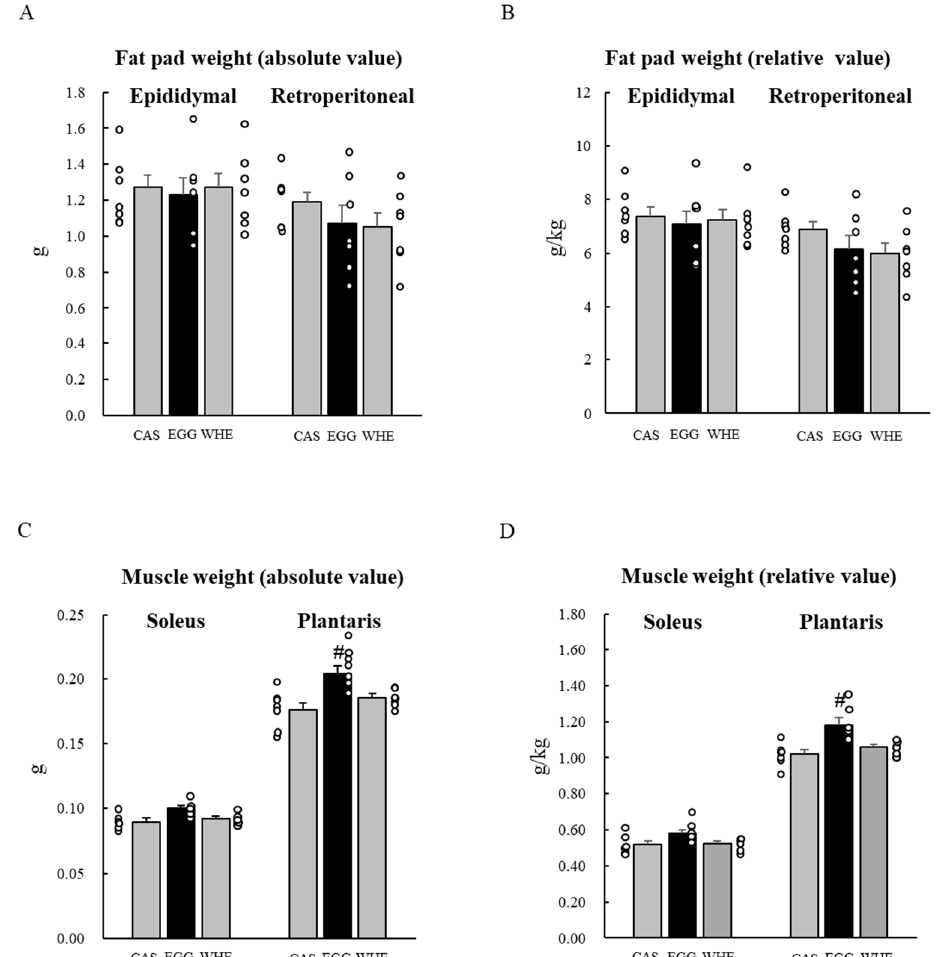
Figure 8. Chronic effect of each protein feeding with arginine-modification on fat pad and muscle weight (Day 7). Rats were assigned to either a casein, egg white, or whey protein diet group, and were maintained under ad libitum feeding for 7 days without clenbuterol administration. On day 7, rats were fasted for 6 h, and then fat pads ( A , B ) and muscles ( C , D ) were dissected out. An absolute value ( A , C ) and a relative value to body weight ( B , D ) were calculated. The dots beside bars indicate individual value. Values are means ± SE ( n = 7). CAS: casein protein, EGG: egg white protein, WHE: whey protein. #: p < 0.05 vs. other two